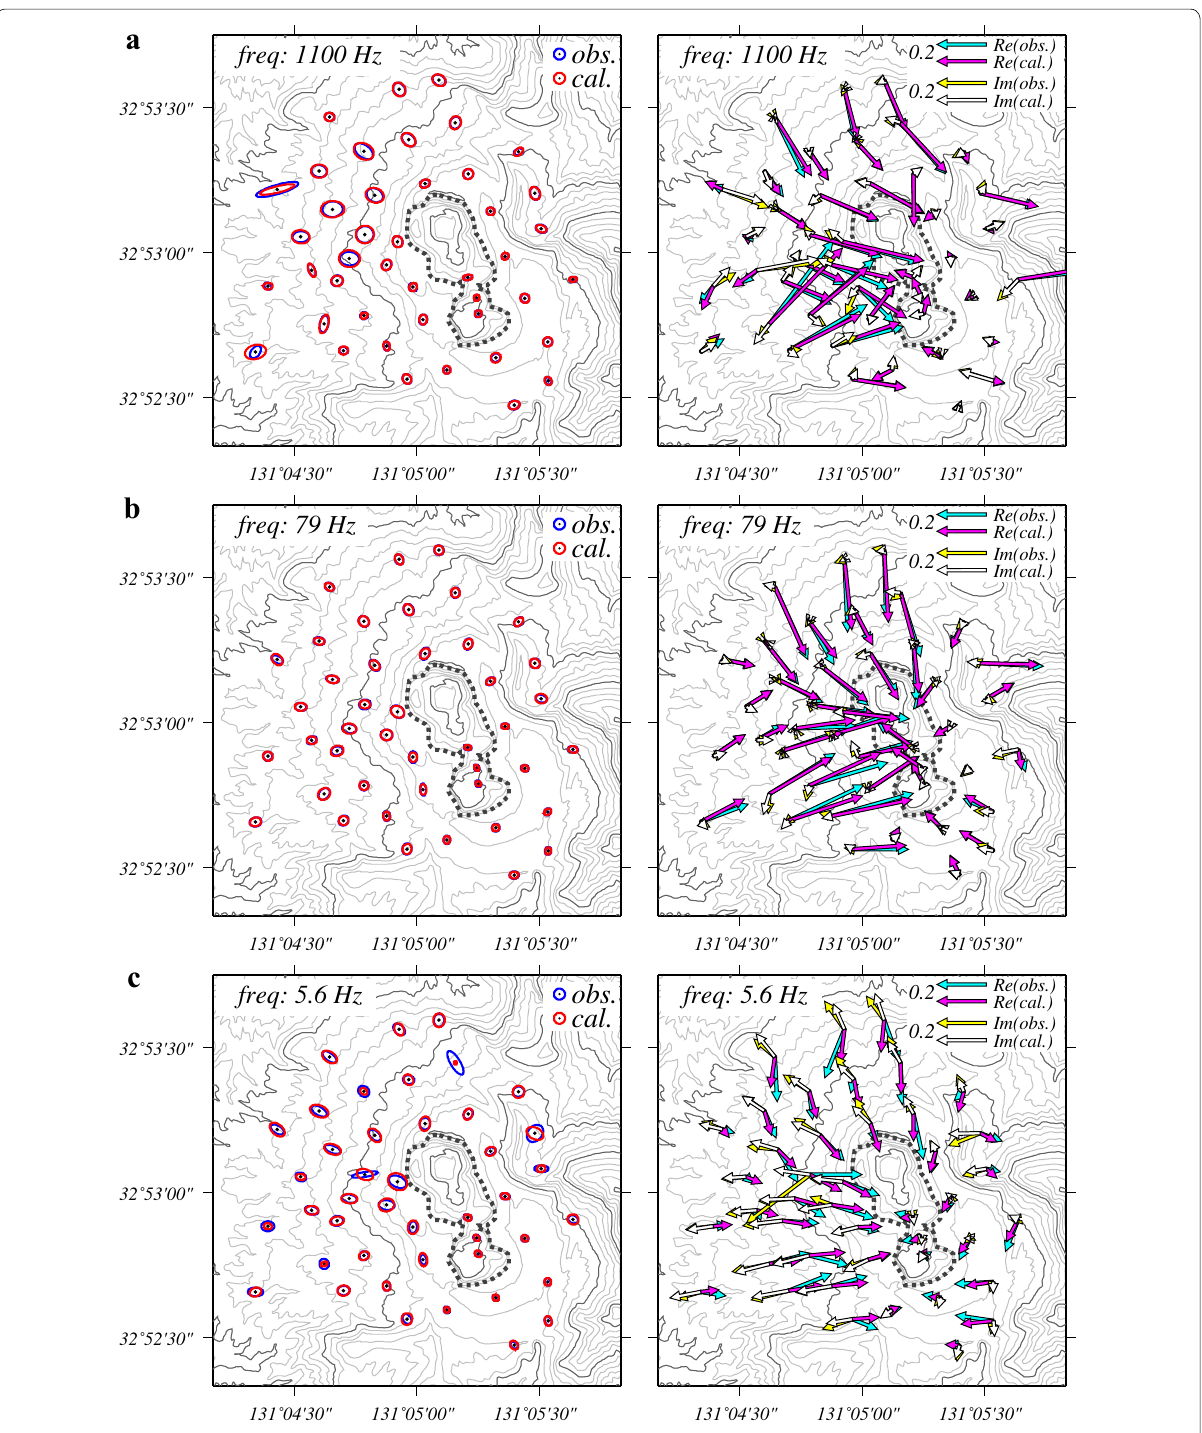
Fig. 3 Comparisons of observed data with the results of the final 3-D resistivity model for three representative frequencies. a Comparison of the phase tensor (left) and induction arrows (right) at 1100 Hz. The left-hand panel shows the elliptical representation of the phase tensor (Caldwell et al. 2004). The right-hand panel shows the real and imaginary induction arrows (Parkinson 1962). b Comparison of the phase tensor (left) and induction arrows (right) at 79 Hz. c Comparison of the phase tensor (left) and induction arrows (right) at 5.6